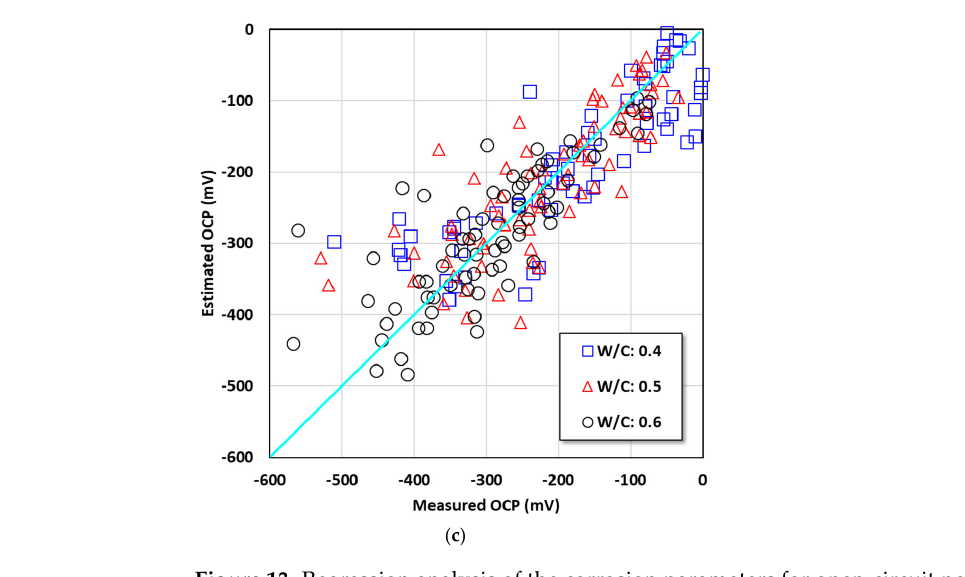
Figure 14. Open-circuit potential (OCP) contour with corrosion parameters: ( a ) wet condition, ( b ) 3.5% concentration, and ( c ) 7.5% concentration.